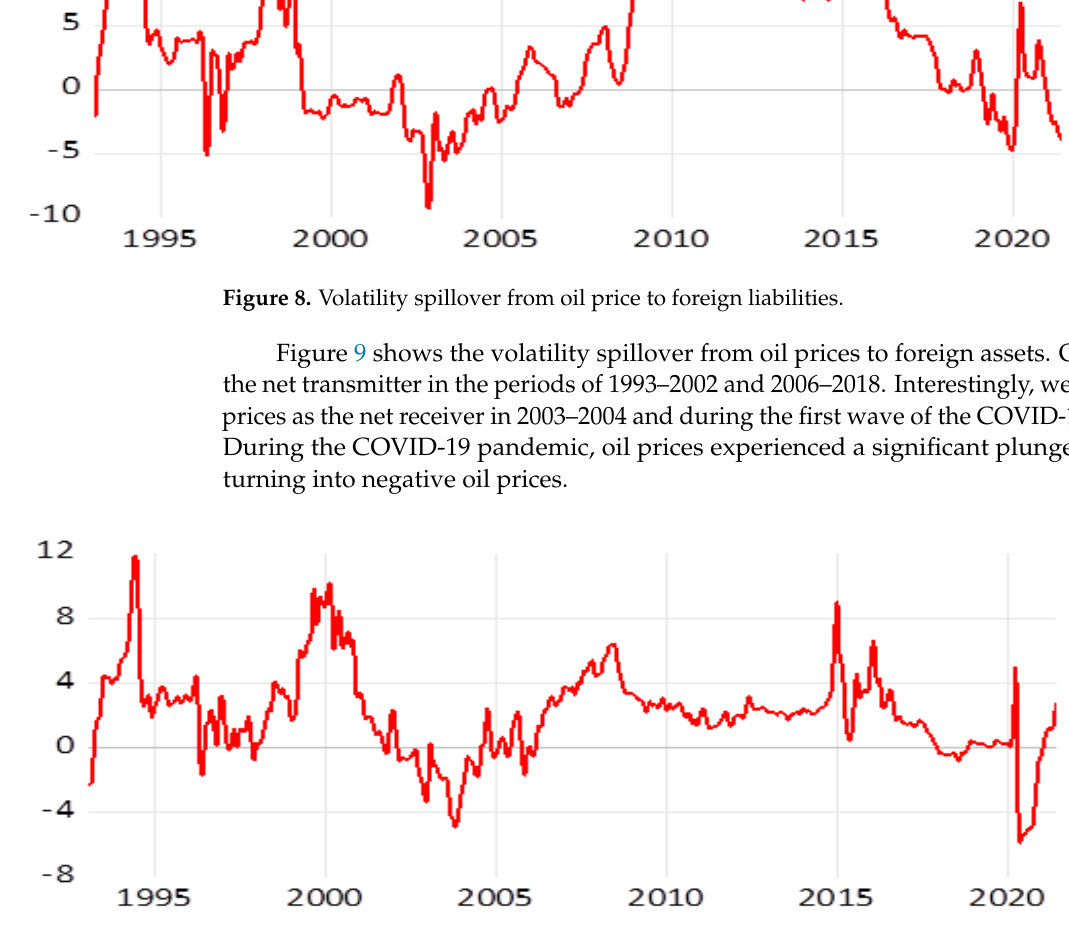
Figure 9. Volatility spillover from oil price to foreign asset.